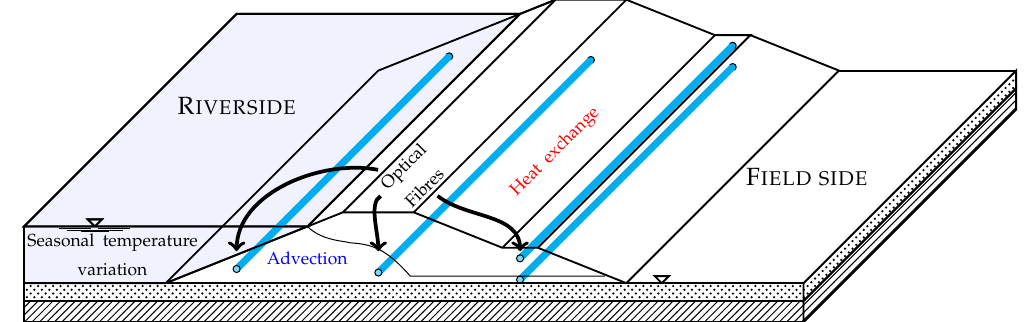
Figure 7. The principle of monitoring for seepage detection by DTS: at the location where fibre crosses a leakage, the temperature shows a gradient. Fibre cable may be installed upstream, downstream, or under the